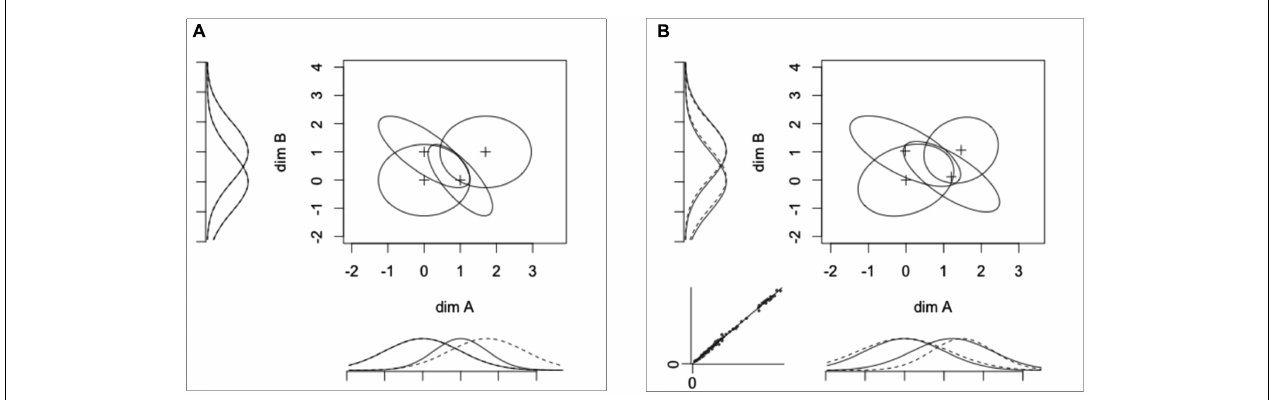
FIGURE 8 | (A) Original GRT-wIND model used to generate the data in our example (see main text) and (B) model recovered by grtools , where marginal distributions for a given dimension are plotted using either solid or dotted lines depending on the level of the opposite dimension, and the bottom-left insert is a plot of the observed response proportions against those predicted by the